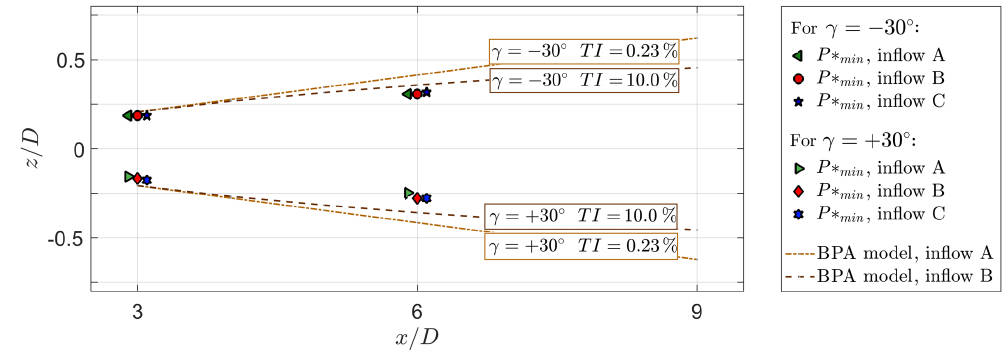
Figure 9. Calculated wake deflection δ ( z/D ) at x/D = 3 and x/D = 6 for three different inflow conditions (A, B and C) compared to TI- dependent deflection predictions by Bastankhah and Porte-Agél’s wake deflection model. Note that a small offset in x/D of the measured values was chosen for better